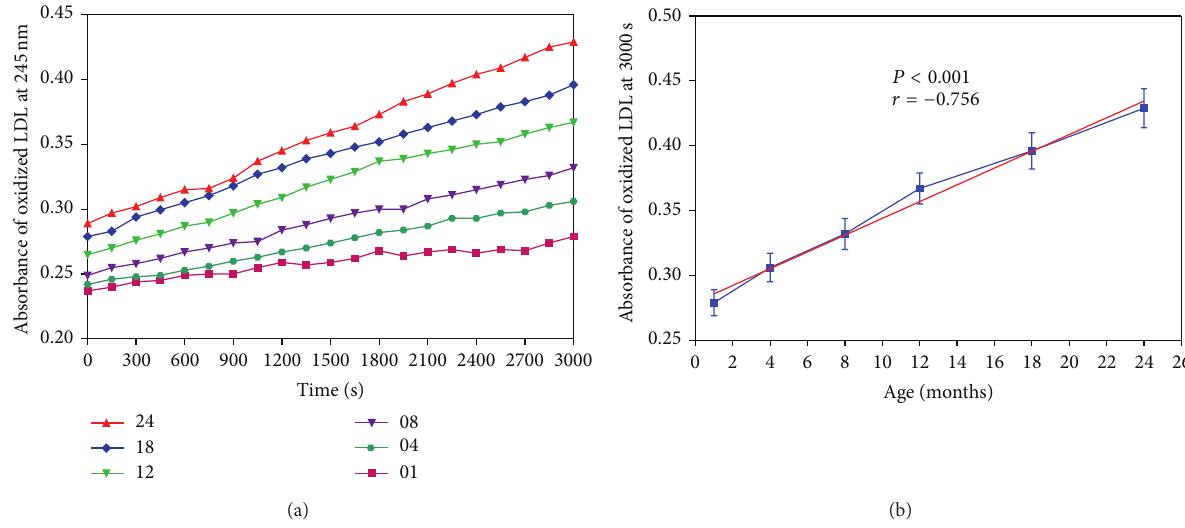
Figure 2: (a) Absorbance at 245 nm as a function of time for induced LDL oxidation in plasma of different age group rats (age in months). (b) The absorbance of oxidized LDL samples at 3000 seconds as a function of rat age (in months). Values are mean ± SEM.